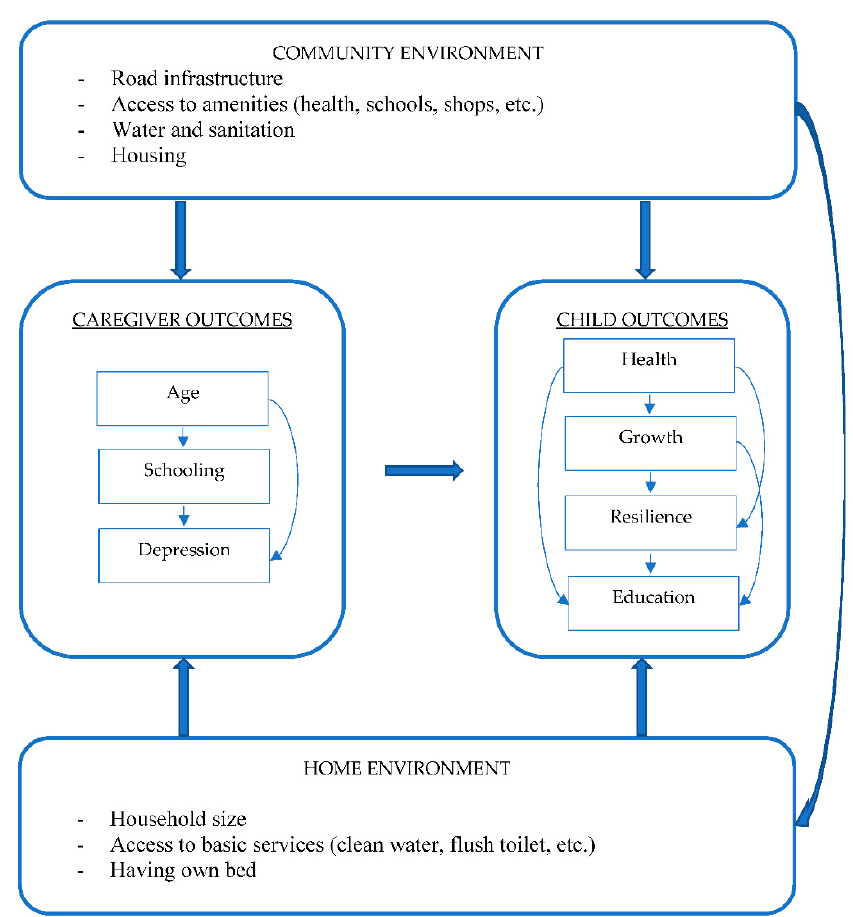
Figure 1. Proposed conceptual framework to demonstrate the potential relationship between individual-, household-, and community-level